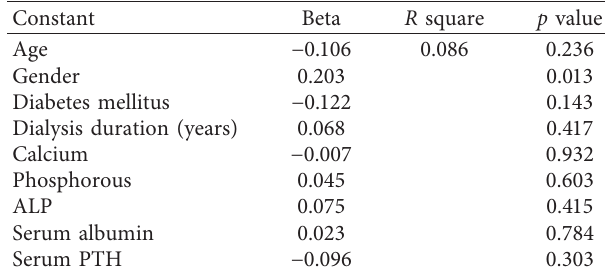
Table 5: Multiple linear regression for predictors of 25 (OH)D level.